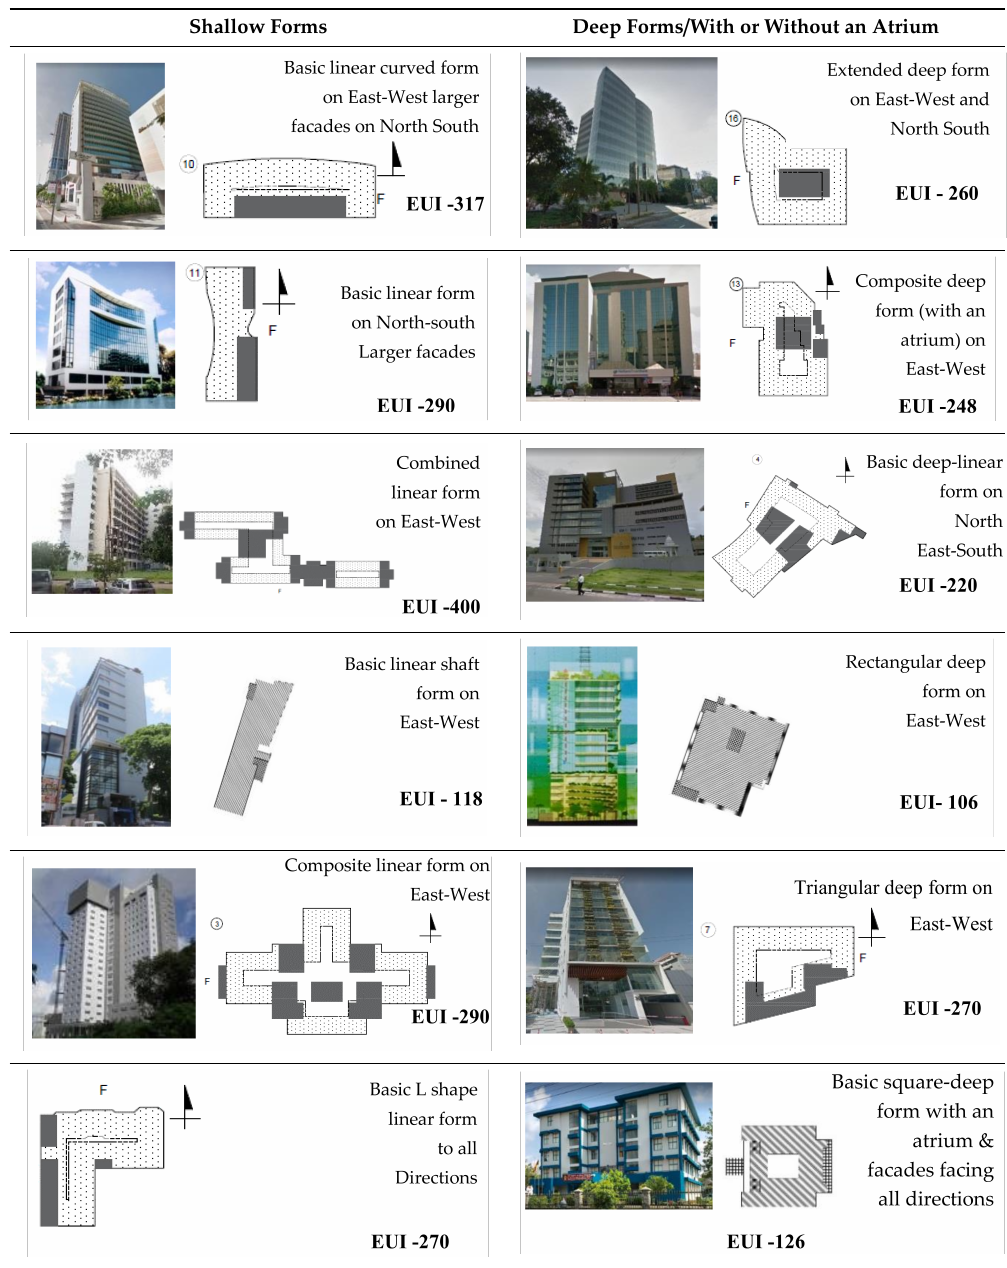
Table 1. A classification of the selected 12 plan forms of o ffi ce buildings from a larger population of 86 buildings in Colombo. Most forms are composite shallow or deep plans, some are with